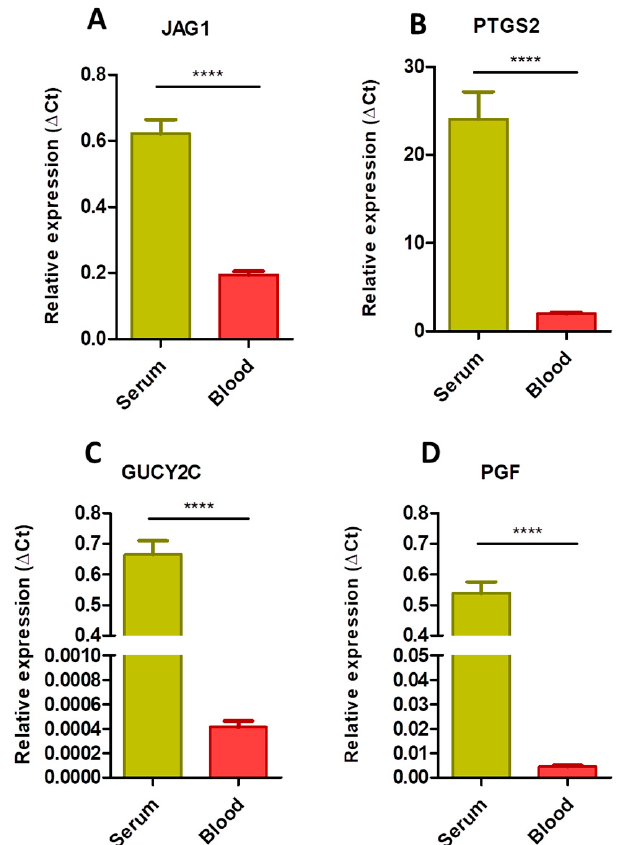
Figure 3. Comparison of gene expression levels obtained by digital PCR in matched serum and blood cell samples from patients with metastatic colon cancer. Expression levels of JAG1 ( A ), PTGS2 ( B ), GUCY2C ( C ) and PGF ( D ) genes were normalized by MTR expression and calculated by the ∆ Ct method (data represent mean ± SEM). (****) p < 0.0001.